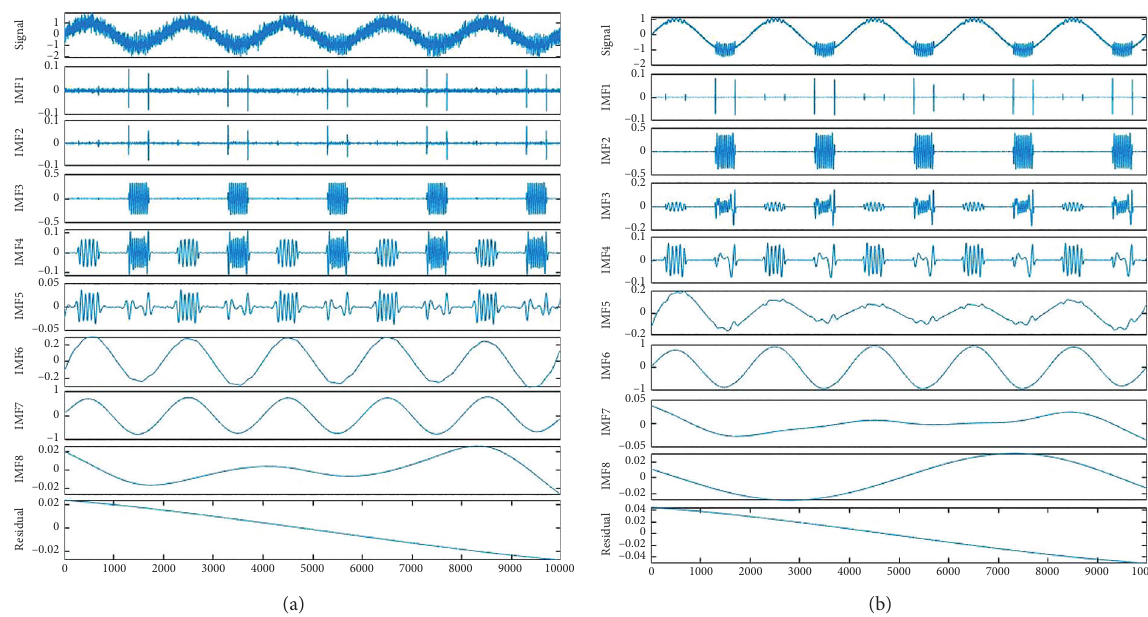
Figure 6: IMFs of EEMD on simulation signal. (a) EEMD with WGN in − 10dBW. (b) EEMD with WGN in −